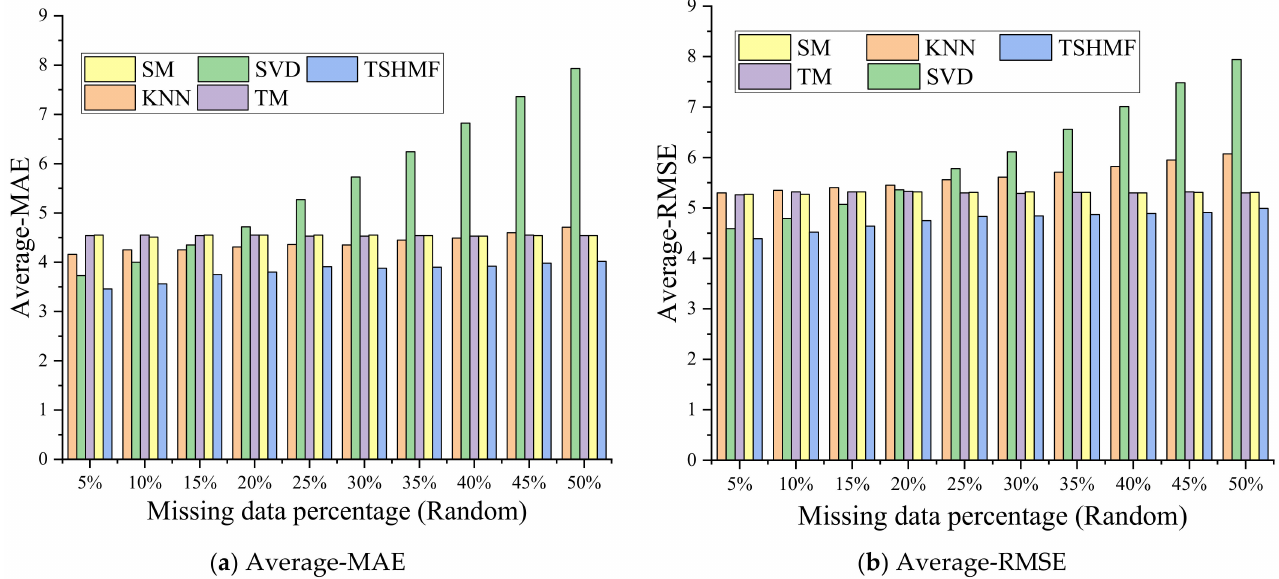
Figure 5. MAE and RMSE averages using different methods with 20 selected GNSS stations (missing ratio = 5 −